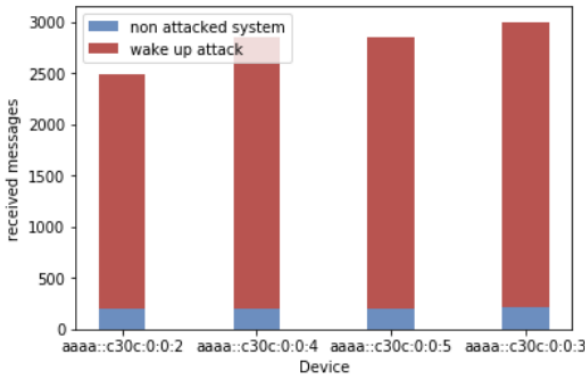
Figure 25. Received messages with attack versus those without